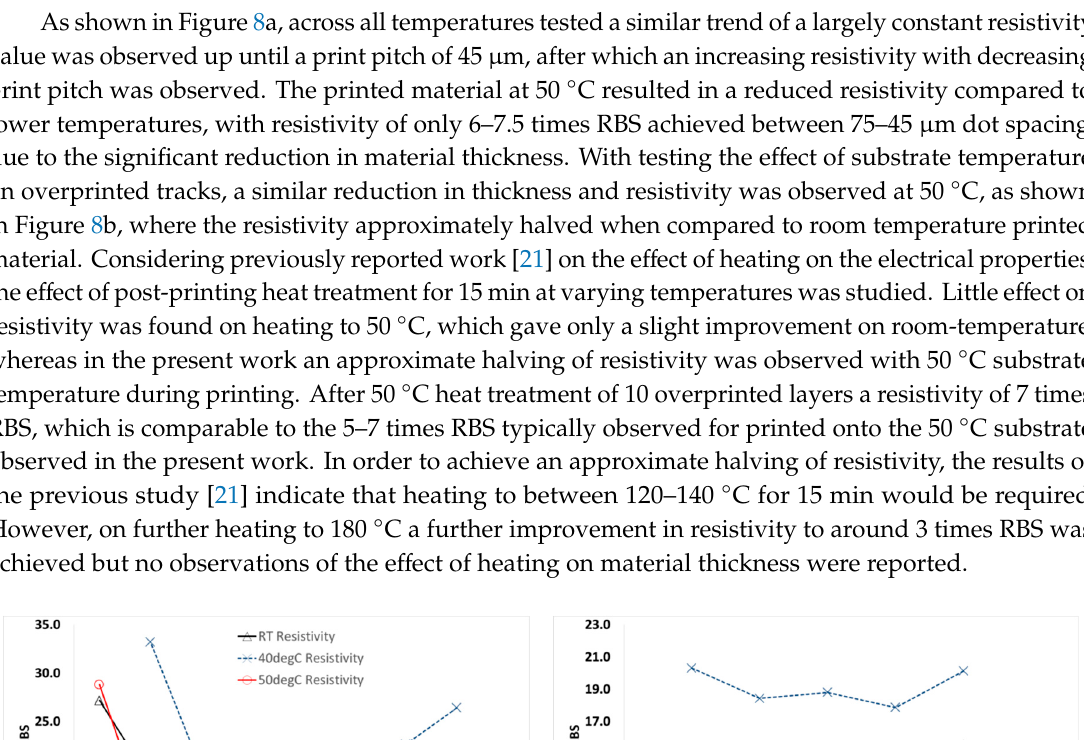
Figure 7. Effect of substrate temperature on ( a ) line width and resistance and ( b ) line thickness with varying print pitch.